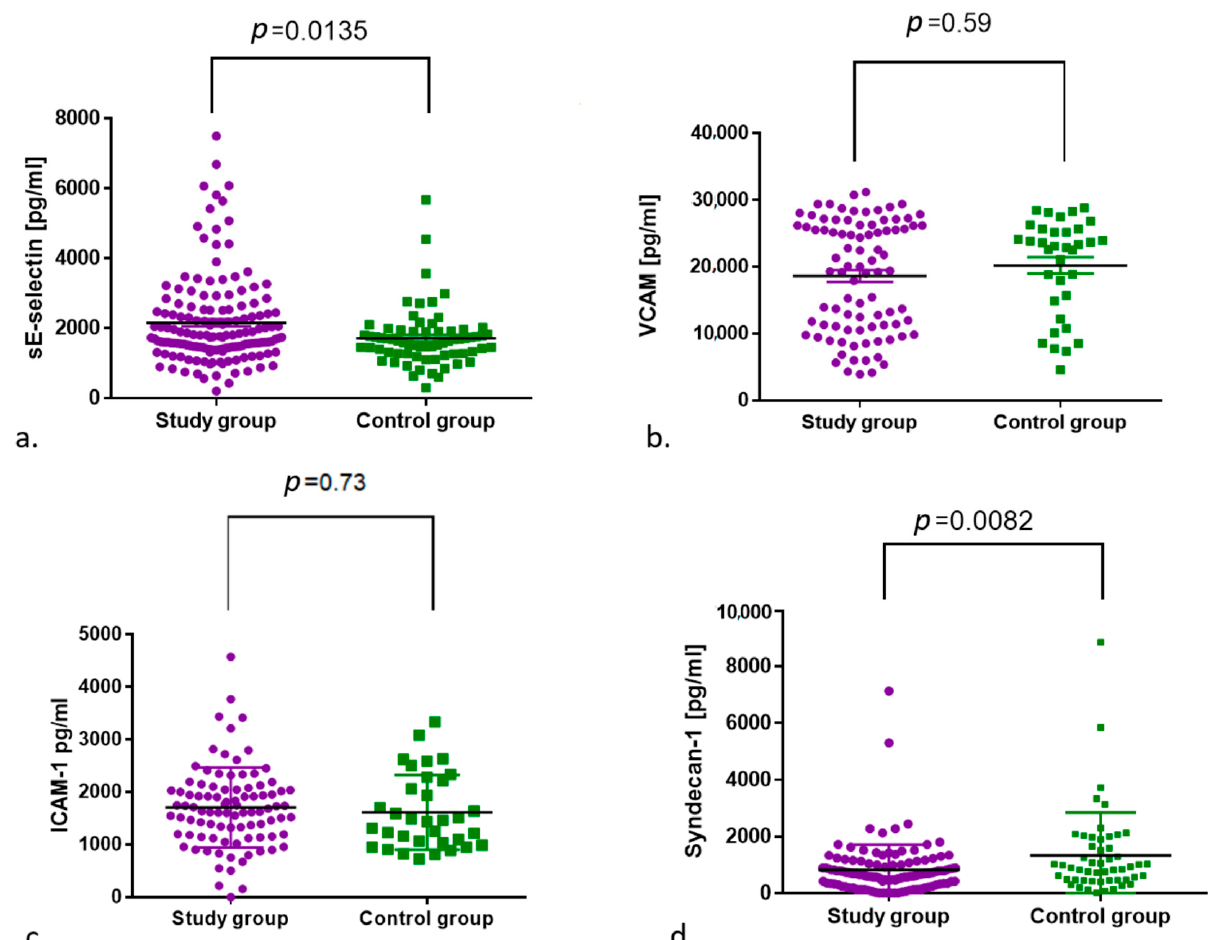
Figure 2. Comparison of ( a ) E-selectin and ( b ) VCAM-1, ( c ) ICAM-1 and ( d ) syndecan-1 concentra- tions between the control and study groups.